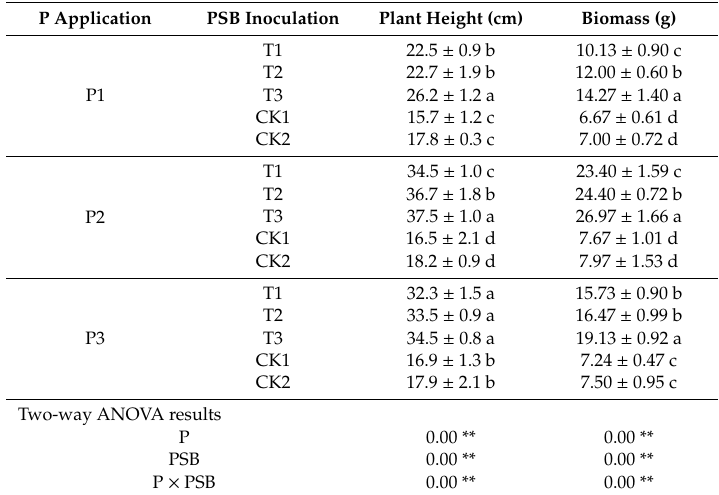
Table 1. E ff ect of PSB on plant height and biomass of C. oleifera seedlings.